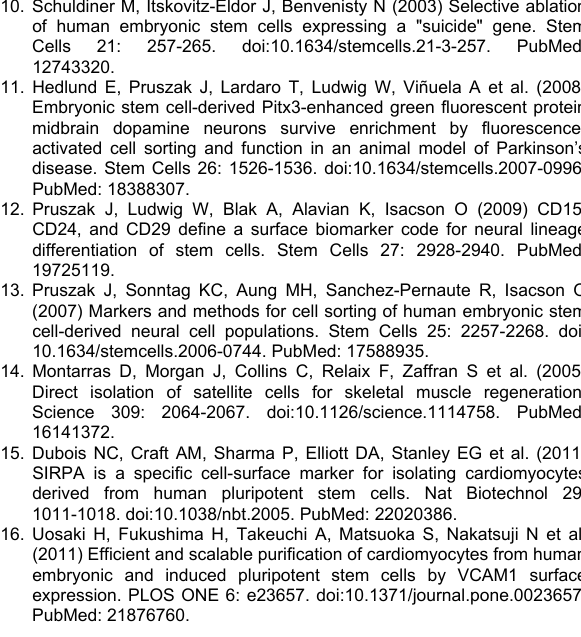
detection on PFA-fixed SH-SY5Y cultures.